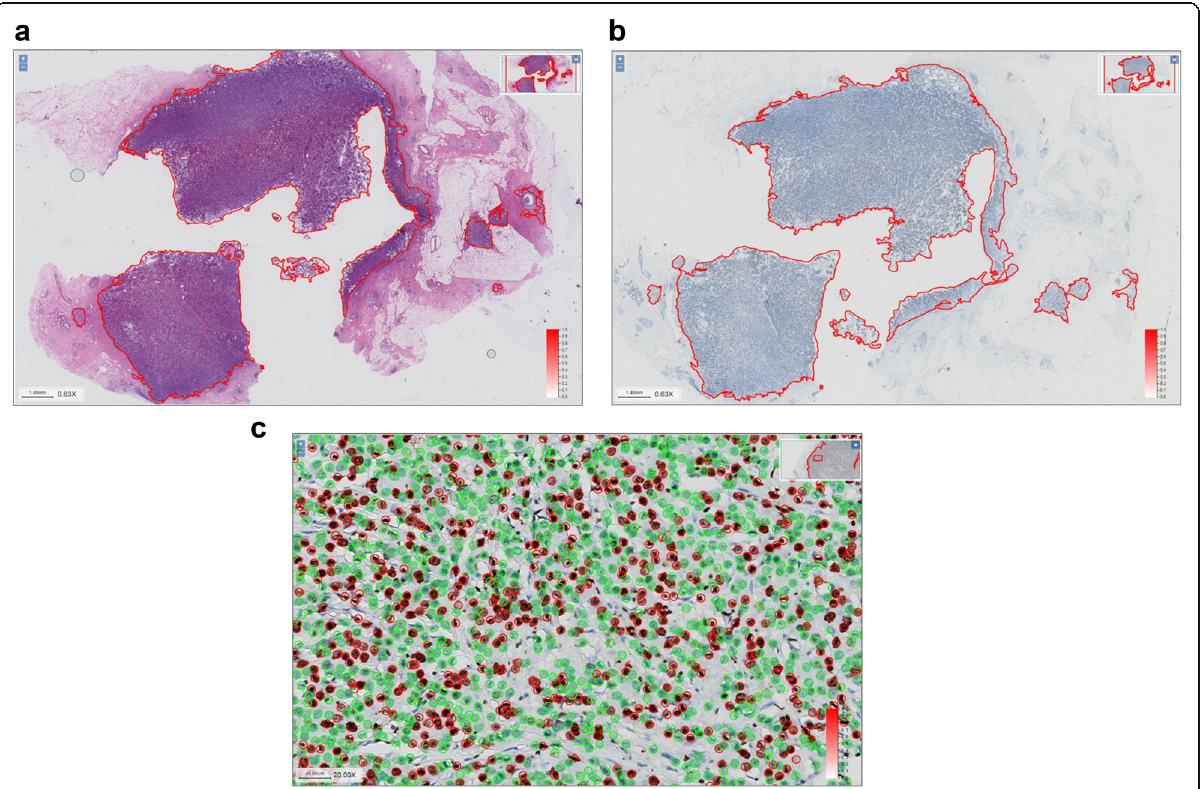
Fig. 5 Manual labelling of “ gold standard ” results for Ki-67 positive cells. a , Selected regions of breast IDC on HE slides. b , Corresponding regions